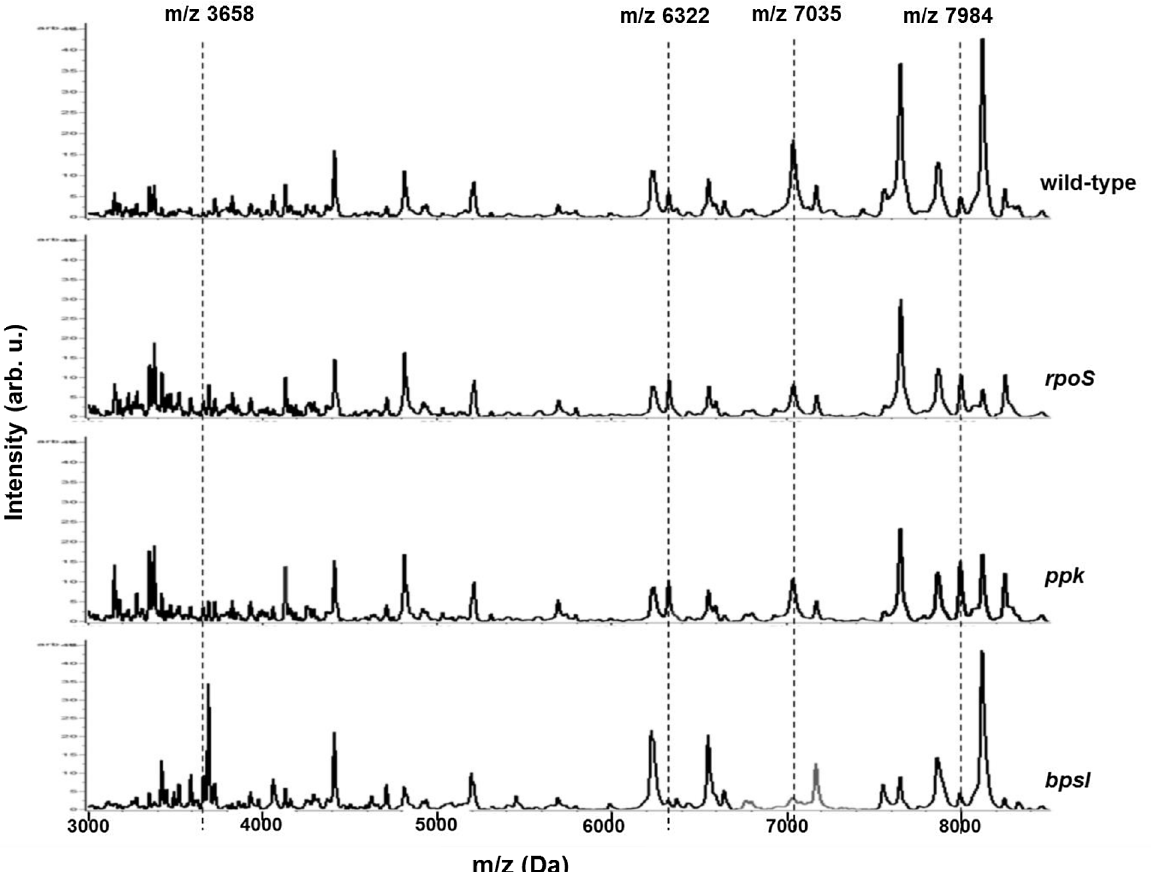
Fig 3. Clinical isolate-specific biomarkers in B . pseudomallei average mass spectra. All four biomarkers, including m/z 3658, 6322, 7035, and 7984 Da, were detected in all of the average mass spectra examined (the vertical dashed lines).